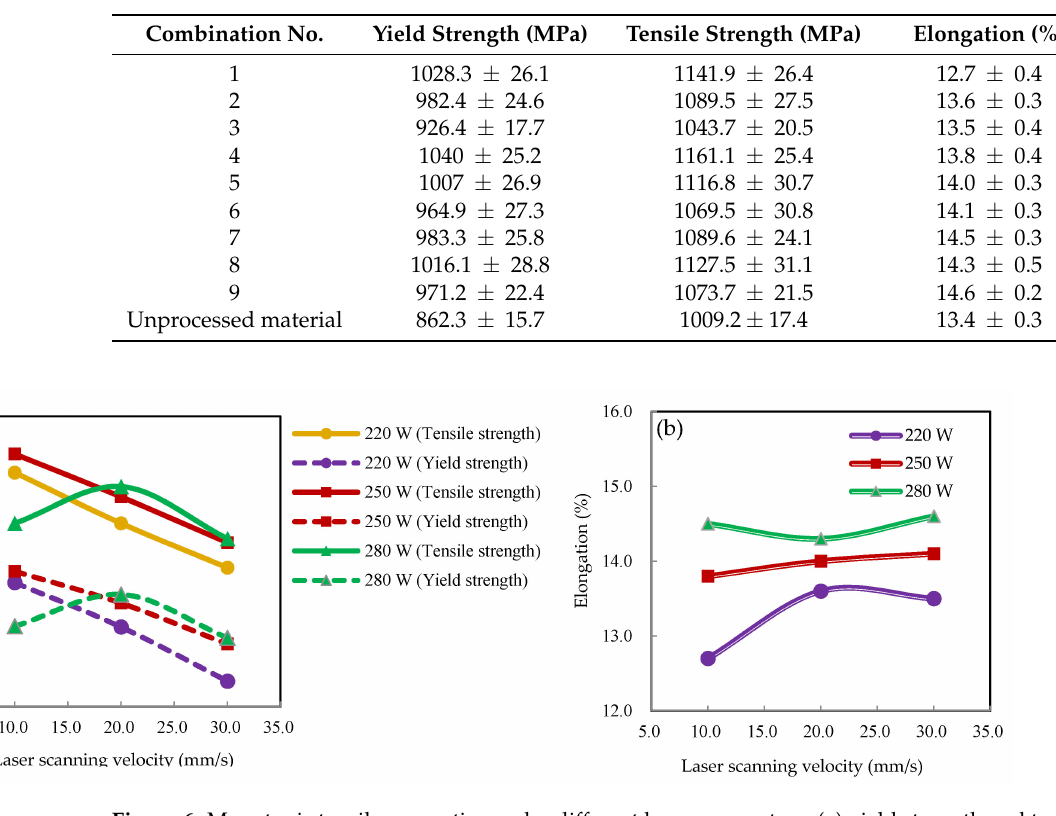
Figure 6. Monotonic tensile properties under different laser parameters: ( a ) yield strength and tensile strength; ( b )